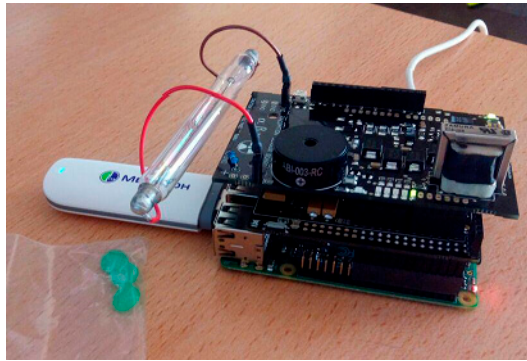
Figure 5. Device with 3G dongle attached.